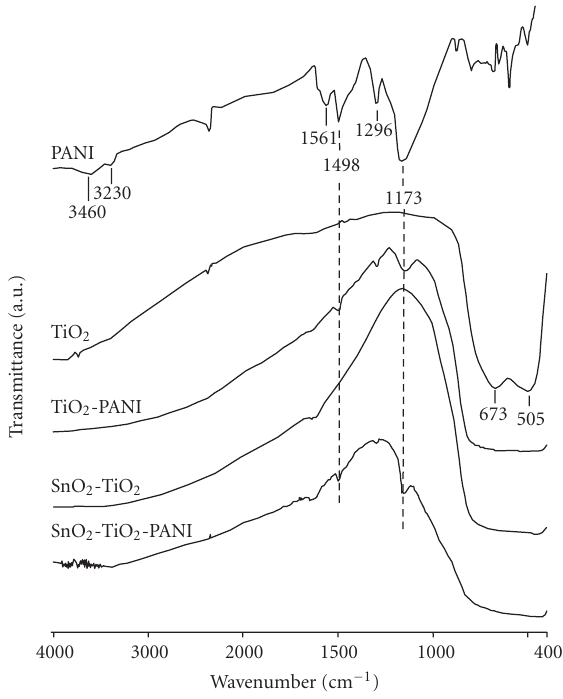
Figure 1: IR spectra of